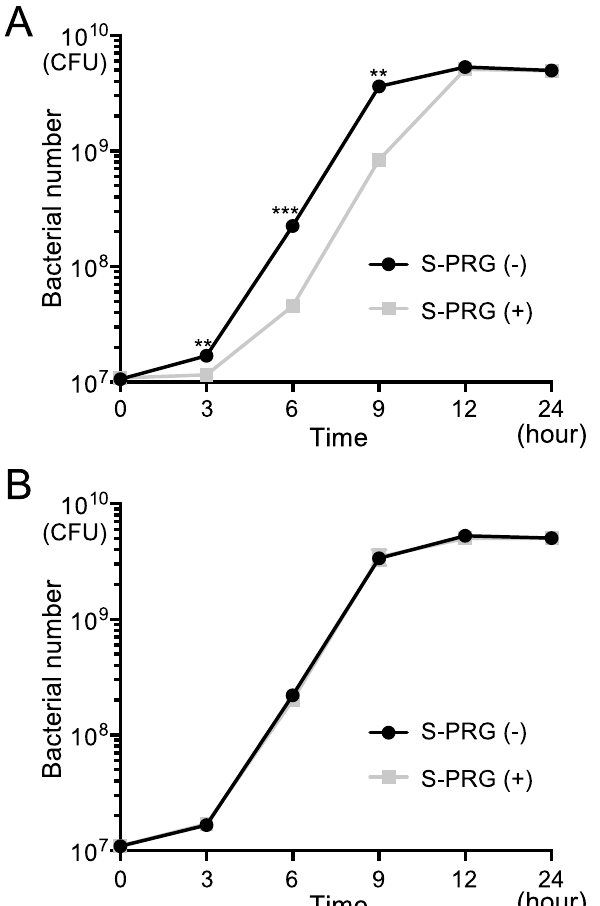
Figure 7. Bacterial growth of S. mutans in the presence of monofilaments. ( A ) Bacterial growth of S. mutans in the presence of nylon monofilaments with and without S-PRG filler at each time point. Significant differences were determined using a chi-square test. ** P < 0.01, *** P < 0.001 compared with nylon monofilaments without S-PRG filler at each time point. ( B ) Bacterial growth of S. mutans in the presence of polyester monofilaments with and without S-PRG filler at each time